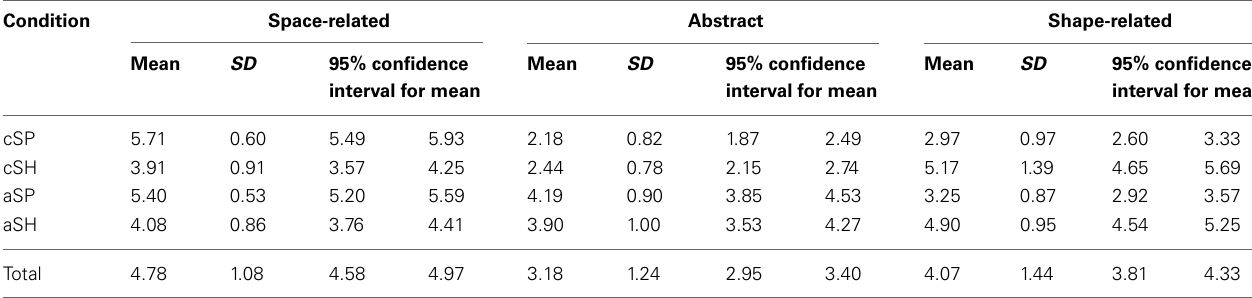
Table 1 | Experimental